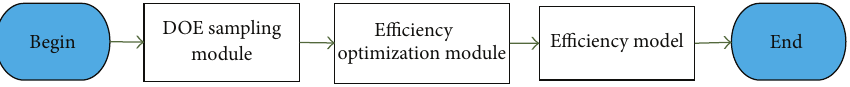
Figure 7: The offline efficiency optimization stream.